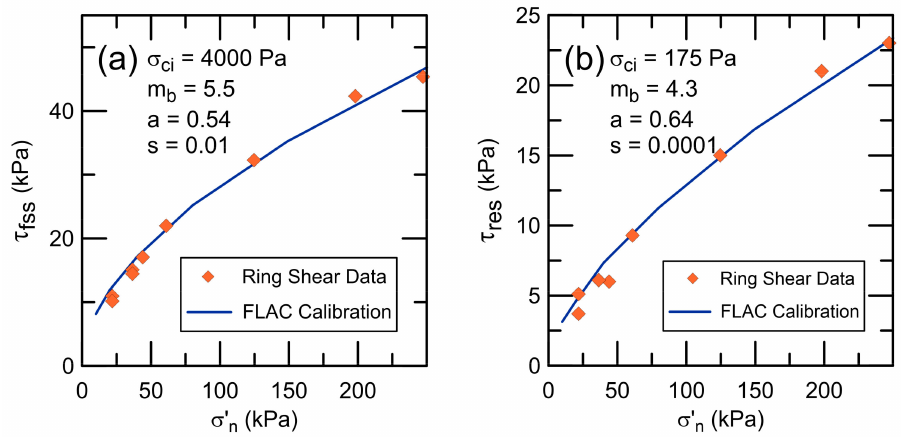
Figure 6. Ring shear data from B6 (1.37 to 1.83 m) and MHB calibration curves to be used in SRM analyses for ( a ) fully softened and ( b ) residual shear strengths. Note: the vertical axis limits are different on each plot and are skewed with respect to the horizontal